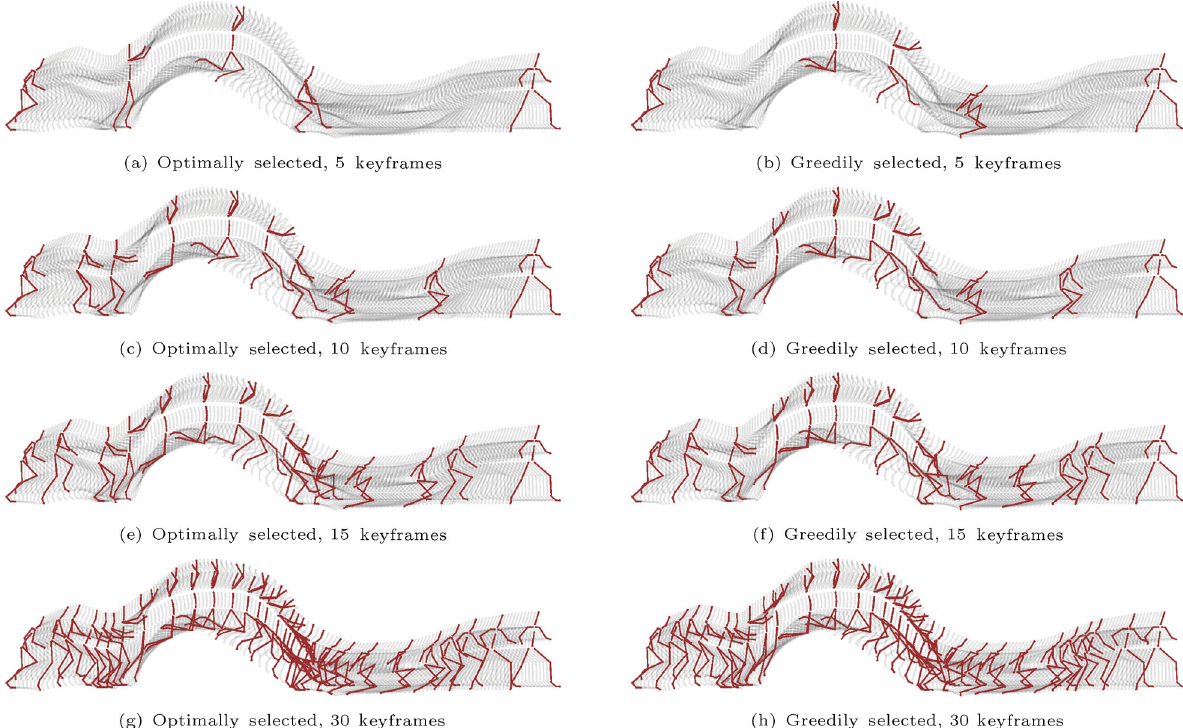
Fig. 8 Time-lapse renders comparing keyframes when selected optimally by Salient Poses (left) and greedily by an approximation algorithm [20] (right). Keyframes of each animation are drawn in red, while the inbetweens are presented in semi-transparent grey. As further keyframes become available, the optimal algorithm is able to distribute the keyframes to best optimize the objective. The distribution of keyframes given by the greedy algorithm is less useful for editing in sparse cases: in (a), three keyframes are used to summarize the downward motion after the jump, while the greedy algorithm selects no keyframes for the prior upward part; as more keyframes become available (c), the greedy algorithm is able to represent both sides of the jump well, but provides no keyframes for the step before the crouching into the jump. Both greedy and optimal solutions become more similar as further keyframes are added.